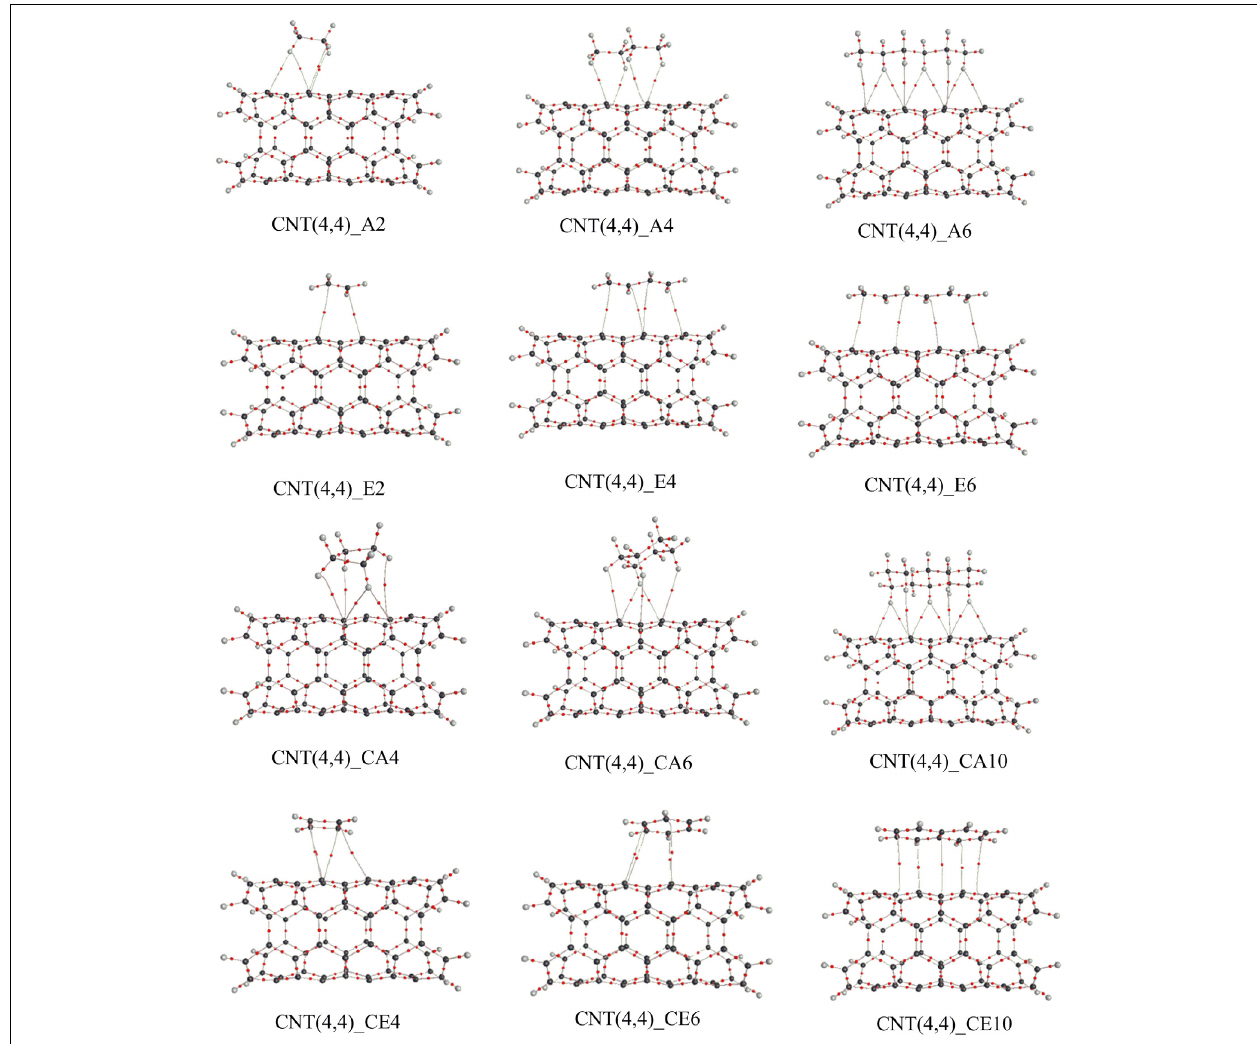
FIGURE 10 | Atomic positions and LCPs of CNT complexes with hydrocarbons obtained at M06-2X/6-31G ∗